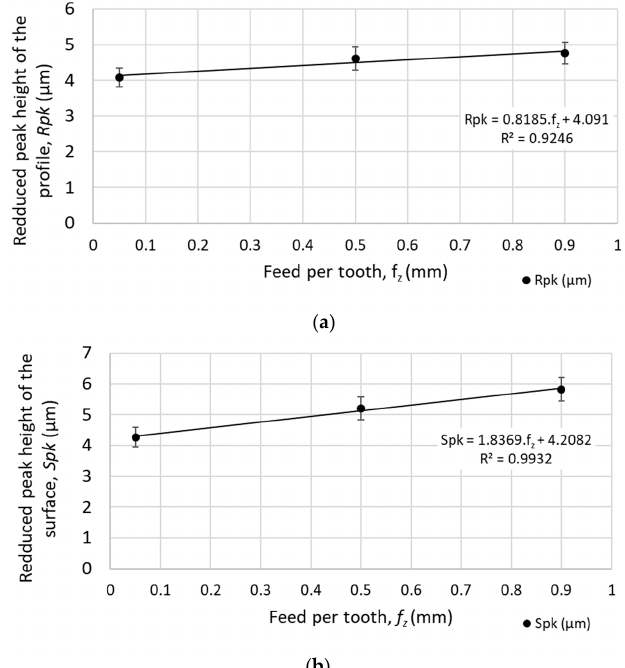
Figure 14. Mean height of peaks above the core material for different feed speeds (at cutting speed v c = 200 m.min − 1 ): ( a ) Rpk - mean height of peaks above the core material for a profile; ( b ) Spk - mean height of peaks above the core material for a selected area. Materials 2019 , 12 , x FOR PEER REVIEW